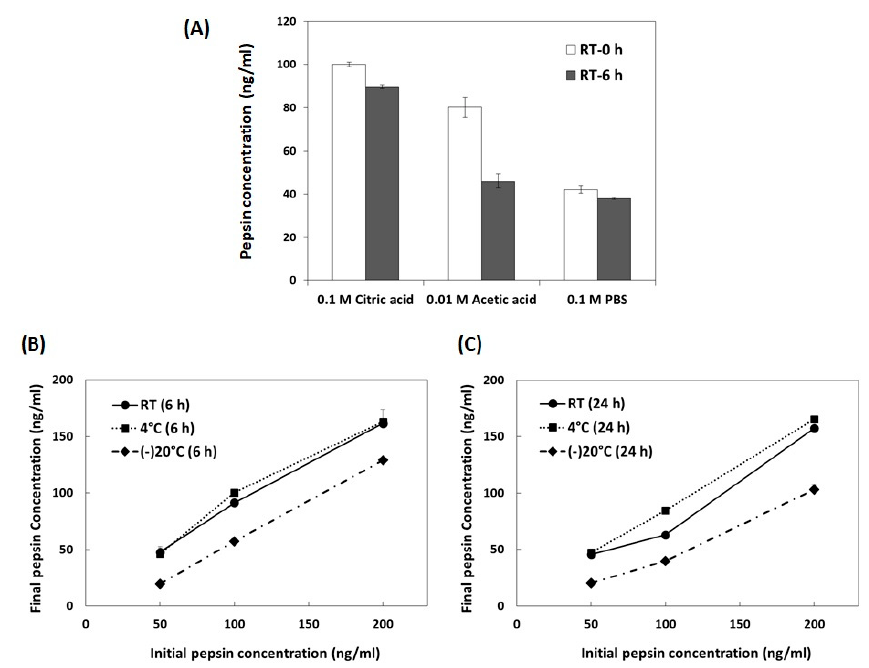
Figure 2. The effects of storage conditions including ( A ) solution, ( B ) temperature, and ( C ) time on the concentration of pepsin. The data are expressed as the mean ± the standard deviation of the mean.